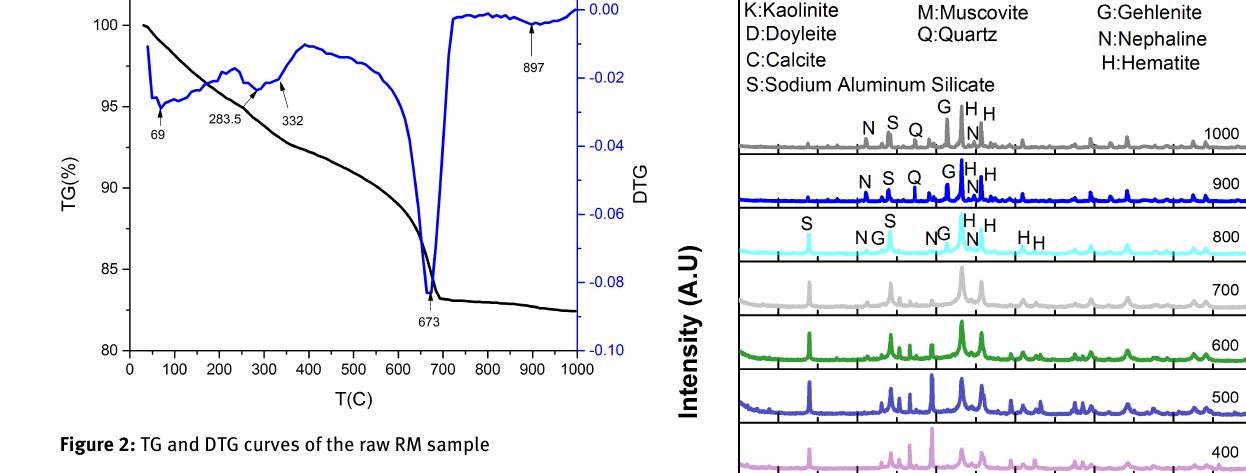
lated points in different stages of transformation by dehy- dration, carbonation and dehydroxylation processes.